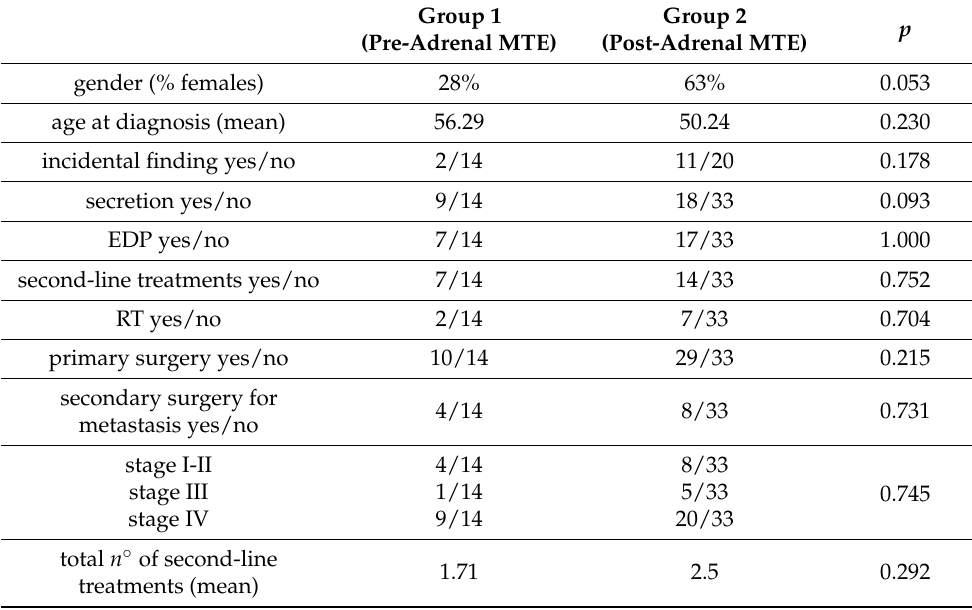
Table 1. Descriptive analysis of the two groups.